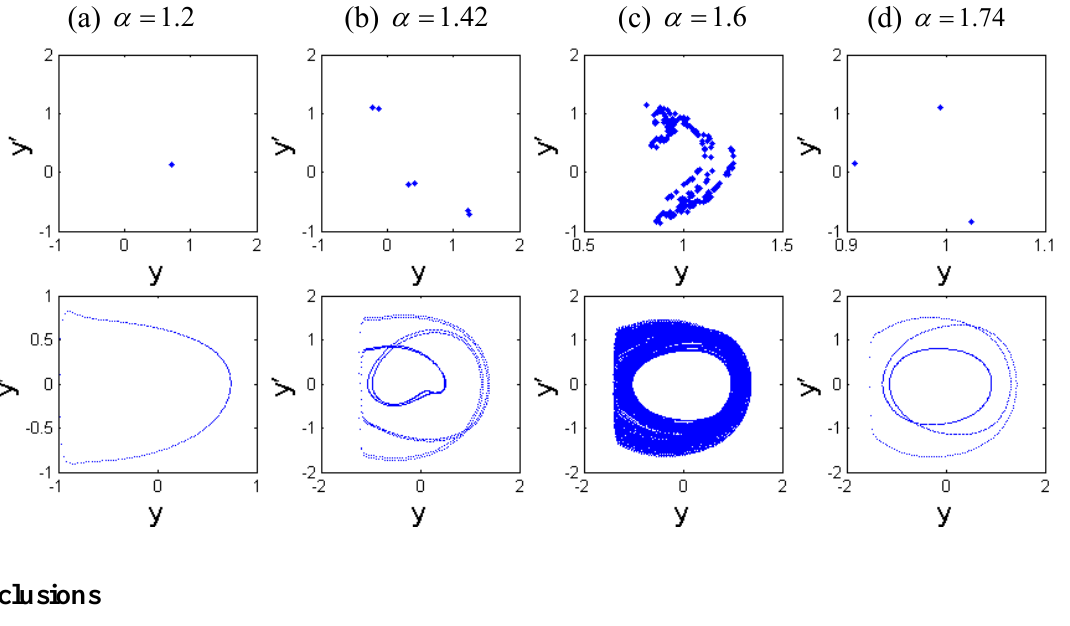
Figure 18. The Poincaré maps and phase portraits of different equilibrium parameters 